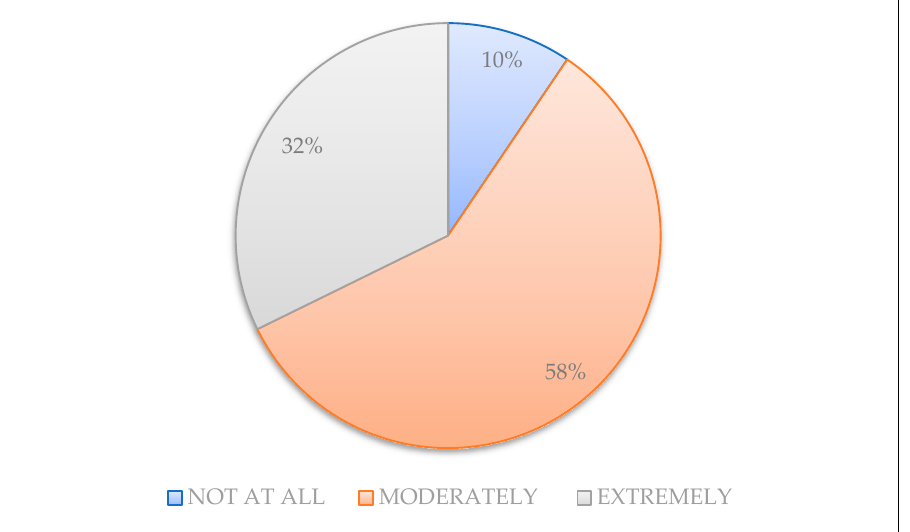
Figure 12. The ability of architectural design to provide social and psychological comfort.